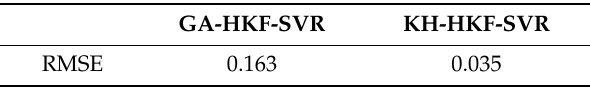
Table 8. Prediction errors comparison. Table 9. Prediction errors